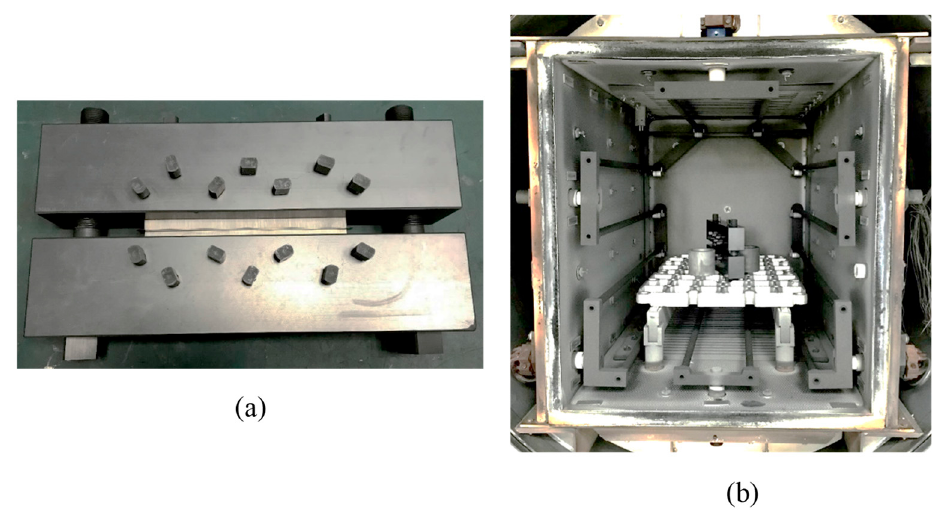
Figure 2. Specimens put in the ( a ) graphite jig, and ( b ) the center of the vacuum furnace with jig.